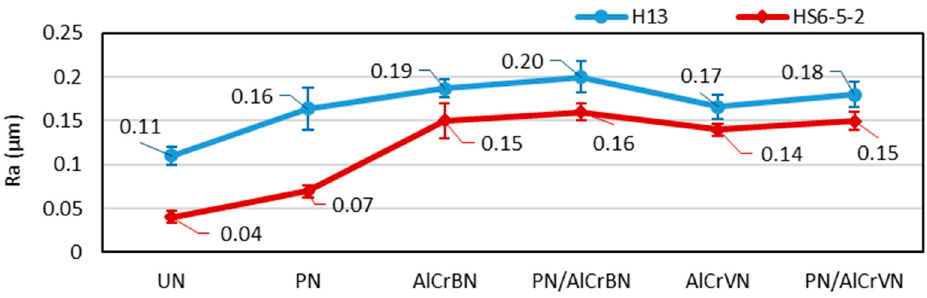
Figure 1. Surface roughness of materials.